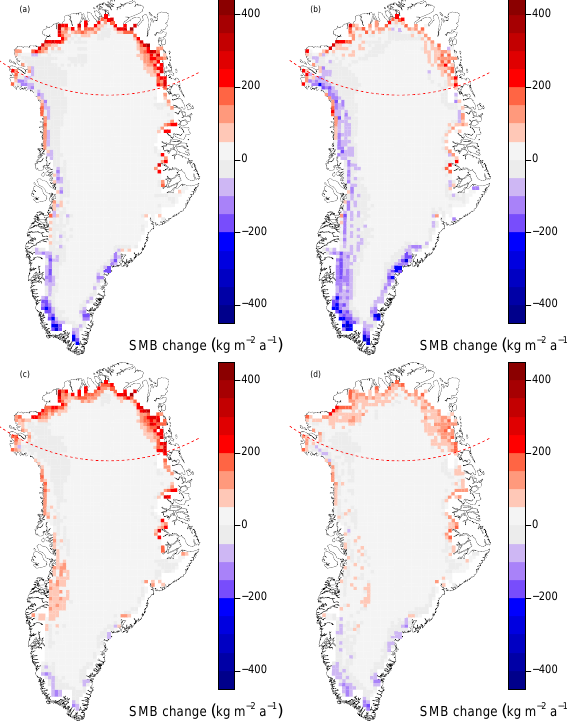
Fig. 3. Mean SMB change (perturbed minus control) in the − 100m (top row) and − 50m (bottom) experiments for the 2000–2019 (left column) and 2080–2099 (right) simulations. Red dashed line is 77 ◦ N.